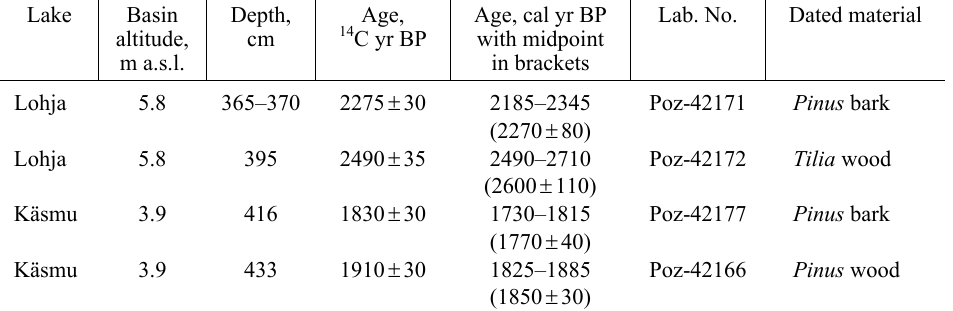
Table 1. AMS radiocarbon dates. The ages have been calibrated according to Reimer et al. (2009) Lake Basin